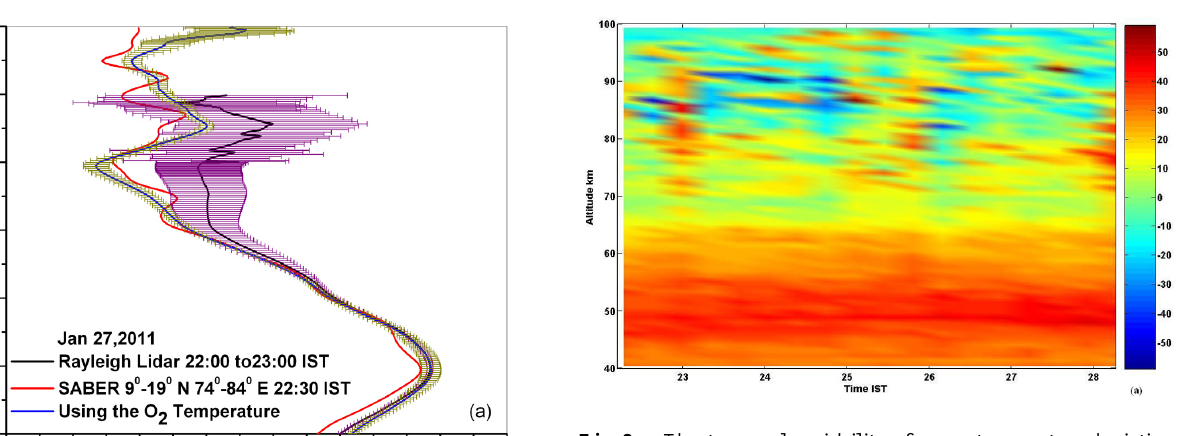
Fig. 3a. The temporal variability of mean temperature deviations (from the mean profile) on 6 January 2011. One may note large amplitudes of waves and their propagation indicating the potential of improvised lidar profiles.